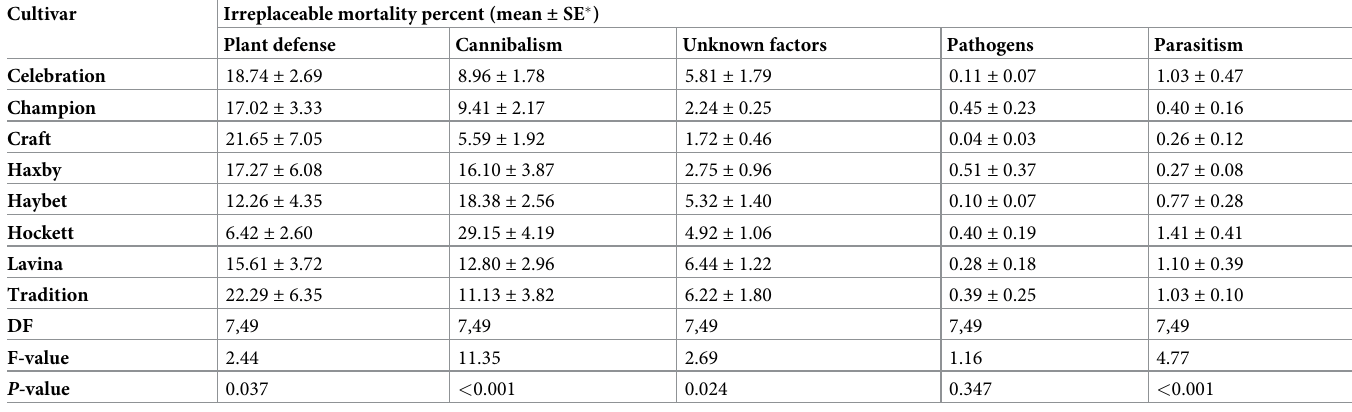
Table 2. Irreplaceable mortality by cause of mortality and cultivar.